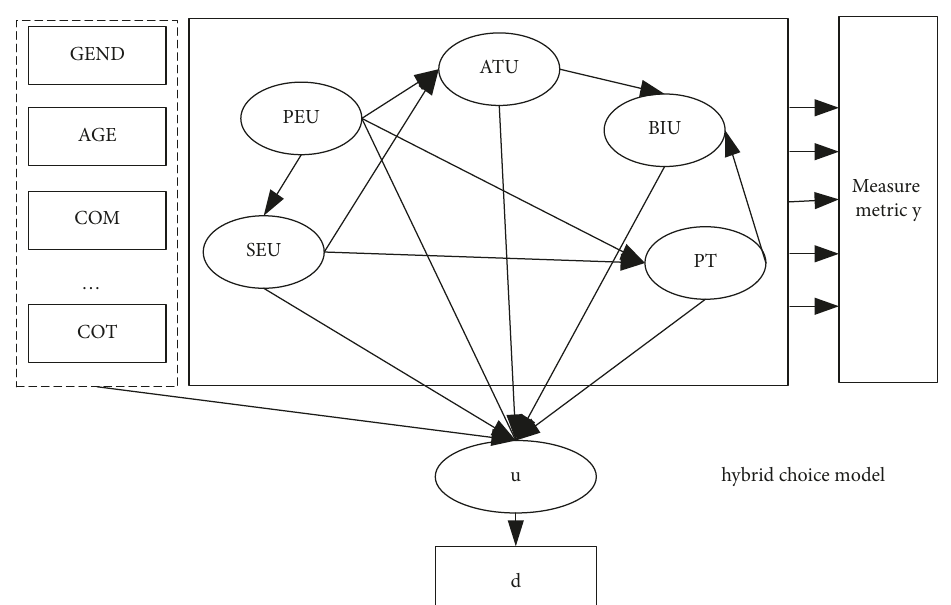
Figure 3: The full path of the